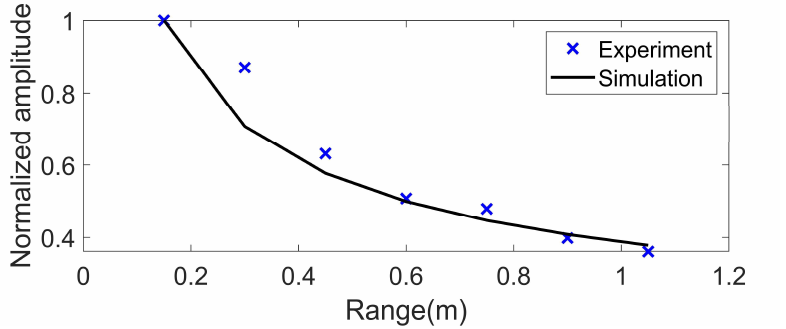
Figure 8. Scholte wave amplitude versus propagation distance. The blue cross is the result of the water tank experiment, and the black line is the simulation